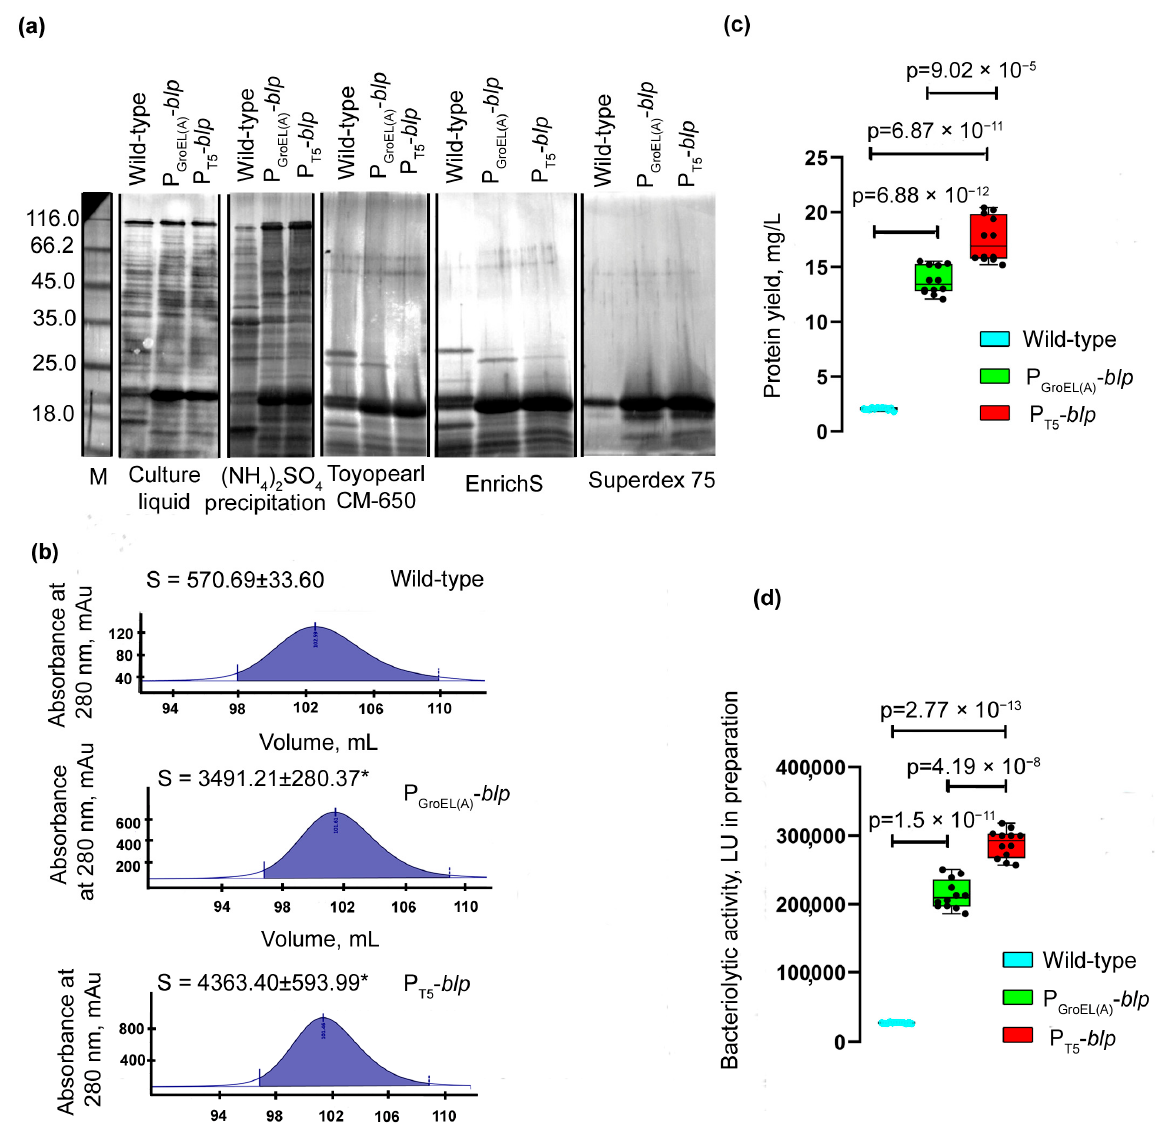
Figure 3. Assessment of efficiency of the developed homologous expression system. ( a ) SDS-PAGE: lanes correspond to samples of the culture liquid of L. capsici strains (Supplementary Figure S2); M and lanes correspond to samples after ammonium sulfate precipitation (Supplementary Figure S3); lanes correspond to samples after Toyopearl CM-650 (Supplementary Figure S3); lanes correspond to samples after EnrichS (Supplementary Figure S4); lanes correspond to samples after Superdex 75 (Supplementary Figure S5). The gel was stained with imidasole–ZnCl 2 solutions. ( b ) β -lytic protease (Blp) peak area the purification on a Hiload 16/60 column (Superdex 75). The mean values were obtained in two independent experiments, each with two technical replicates. The two groups were compared using a two-sided Mann–Whitney U -test ( p = 0.0286). ( c ) Comparison of the Blp yields in L. capsici strains. The boxplots show the median and IQR. The values were obtained in two independent experiments, each with six technical replicates. Statistical analysis was performed using a Welch ANOVA followed by Tamhane’s T2 test for multiple comparisons, p < 1 × 10 − 15 , W (2, 14.82) = 827.8. ( d ) Comparison of the bacteriolytic activity in the culture liquid of L. capsici strains. The boxplots show the median and IQR. The values were obtained in two independent experiments, each with six technical replicates. Statistical analysis was performed using a Welch ANOVA followed by Tamhane’s T2 test for multiple comparisons, * p < 1 × 10 − 15 , W (2, 14.72) =